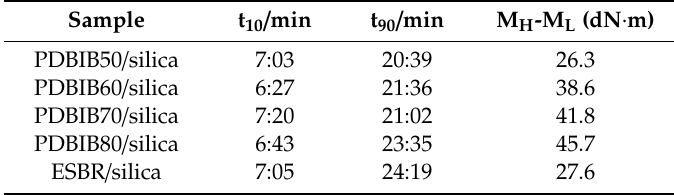
Table 5. Curing for the PDBIB/silica and ESBR/silica compound rubber.